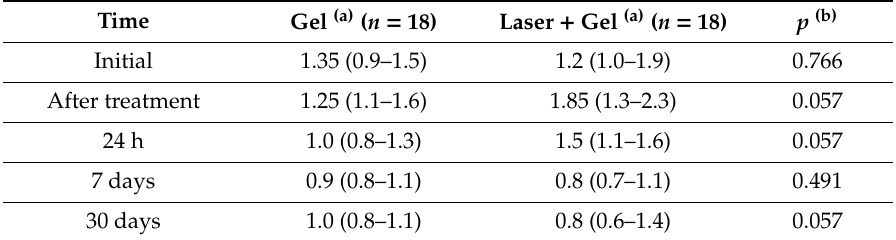
Table 4. Variability of flowmetry values in the laser-Doppler 1.5 min recordings: standard deviation of values recorded for individual teeth.